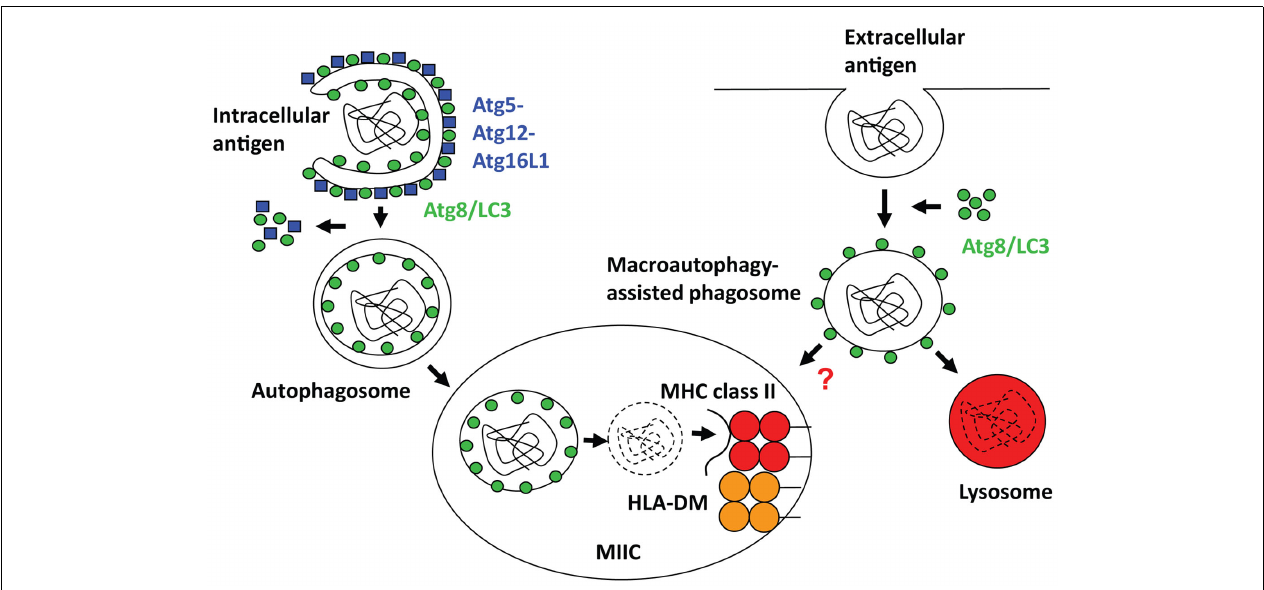
with the assistance of HLA-DM (H2-M in mice). Right side: phagosomes, especially those carryingToll-like receptor (TLR) ligands or apoptotic cells, get decorated with Atg8/LC3, which enhances fusion with lysosomes, and might also increase fusion with MIICs for antigen loading onto MHC class II